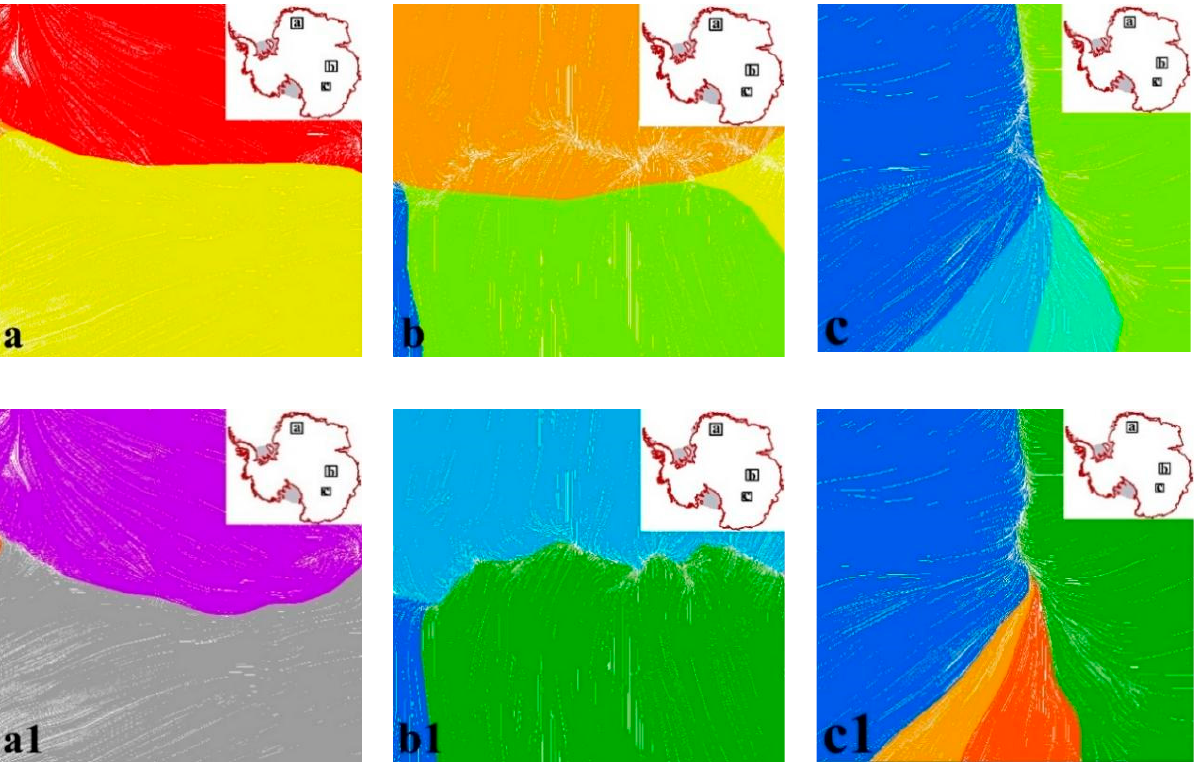
Figure 12. Parts of detailed comparisons at the boundary of the basins between IMBIE basin systems and re-divided Antarctica basin systems. The ice flow lines belonging to different basins are rendered in different colors, where the first row ( a – c ) is the IMBIE basin systems and the second row ( a1 – c1 ) is the corresponding re-divided Antarctica basin